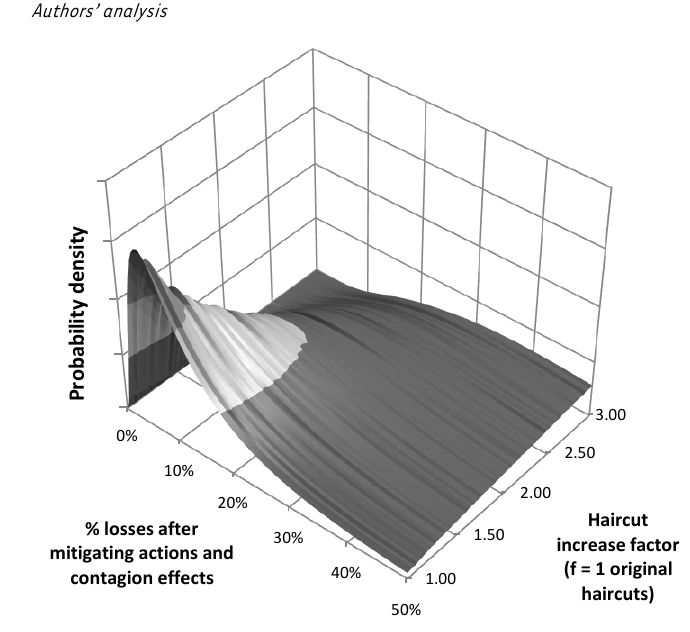
FIGURE 14: SA 2009, buffer restoration model output showing loss dependence on